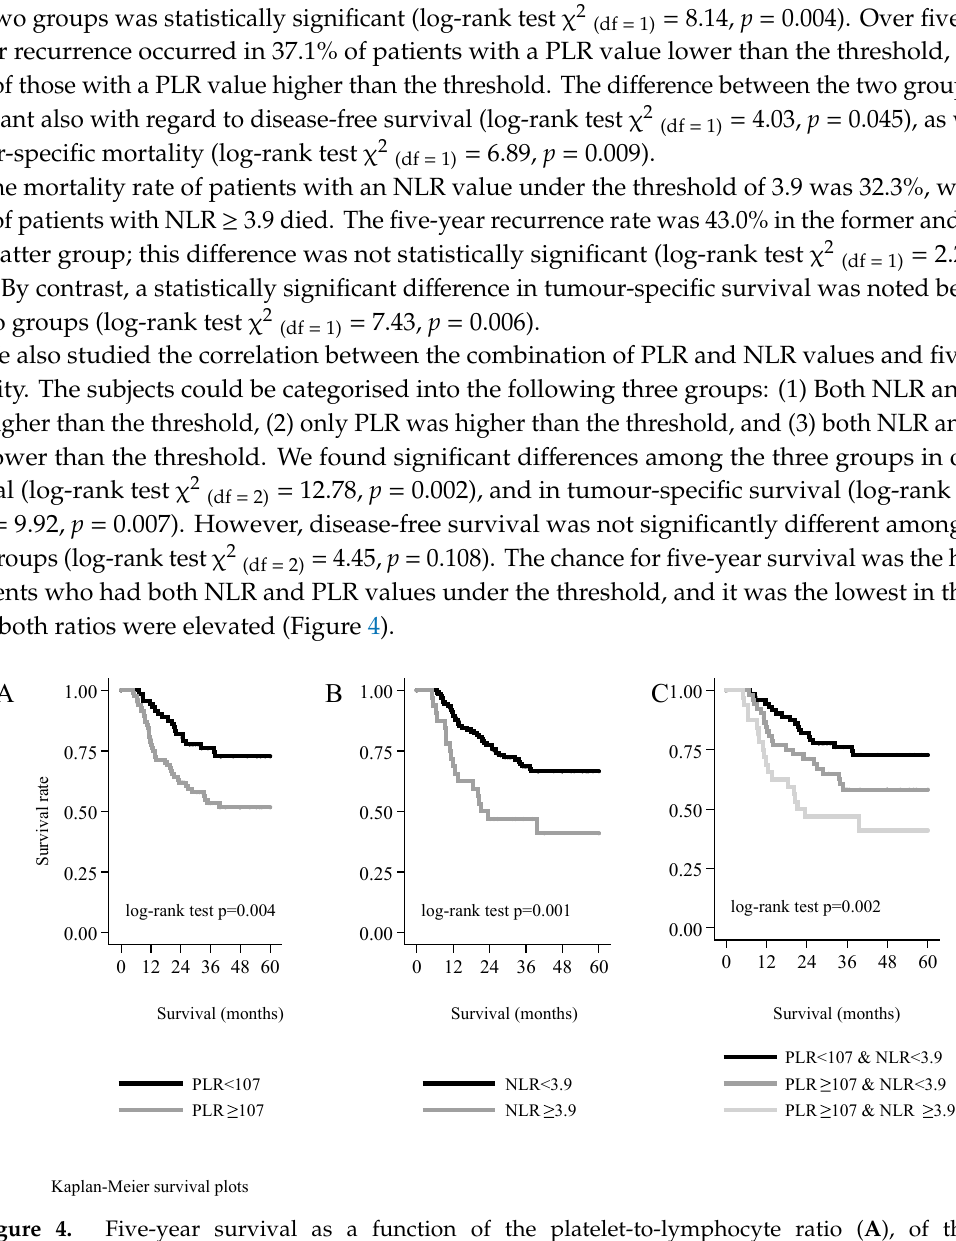
Figure 4. Five-year survival as a function of the platelet-to-lymphocyte ratio ( A ), of the neutrophil-to-lymphocyte ratio ( B ), or of both markers ( C ).